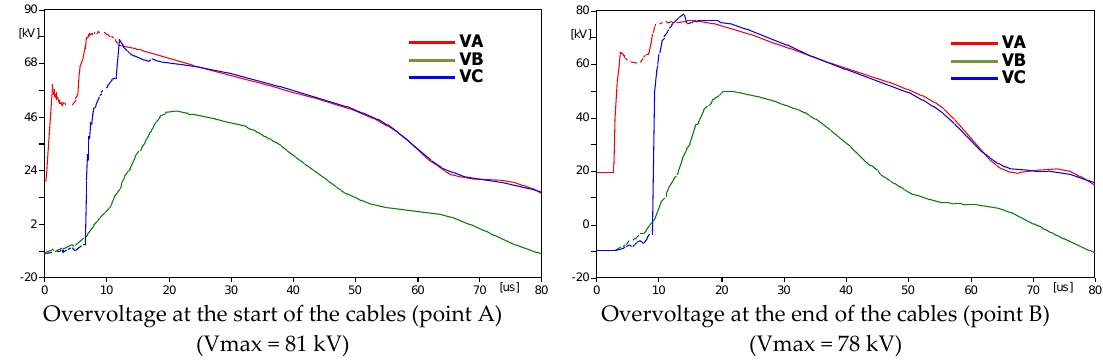
Figure 45. A 400 m underground cable.